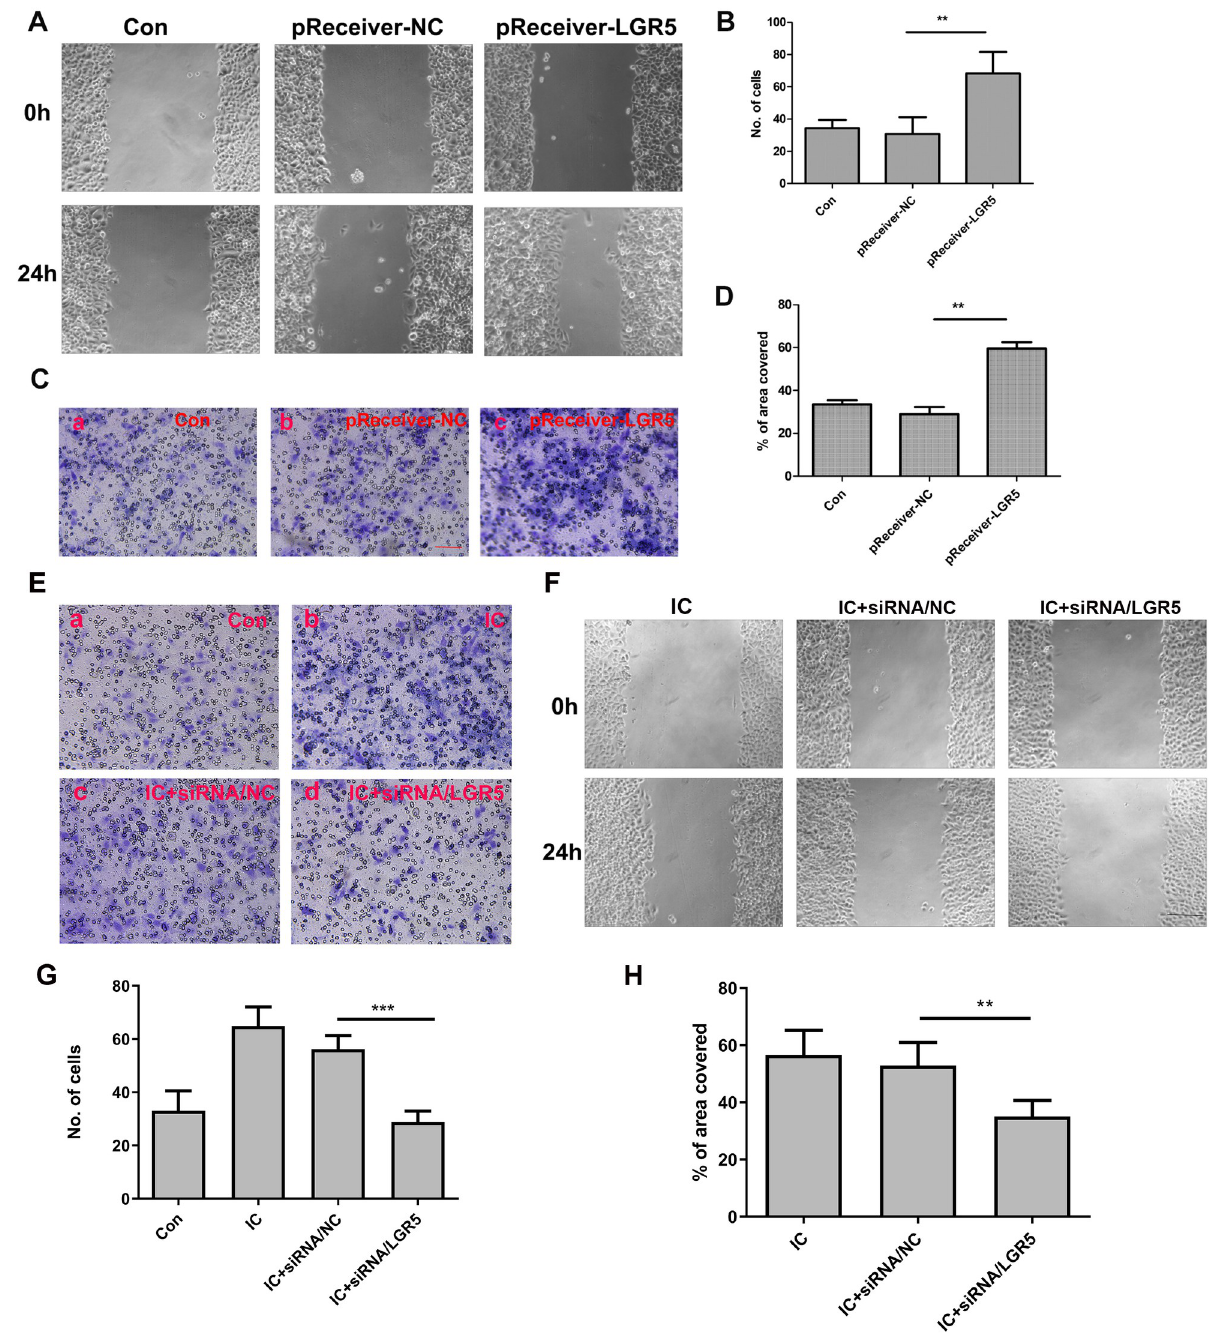
Fig 4. Effects of LGR5 overexpression on tumor cell invasion and proliferation. A, D, F, H: The effect of LGR5 expression on cell migration was detected by the wound healing assay. The percentage of wound healing distance between cell scratches in each group was compared after 24 hours. The outcomes demonstrated that following LGR5 overexpression, the capacity for cell migration was improved. Quantification (D) and representative imaging (A) are shown. Scale bar = 50 μ m. B, C, E, G: The Transwell assay was used to test the invasiveness of the cells. According to the quantitative (B) and representative imaging(C) results, both LGR5 overexpression and the inflammatory condition can lead to enhanced cell invasion ability. However, when LGR5 expression is inhibited, the invasion ability stimulated by IC was reduced. Scale bar = 20 μ m. Statistical significance is denoted by �� P < 0.01, ��� P < 0.001. Con: control group; pReceiver-NC: negative control plasmid; pReceiver-LGR5: LGR5 overexpression plasmid; IC: inflammatory condition; siRNA/NC: negative control siRNA; siRNA/LGR5: LGR5